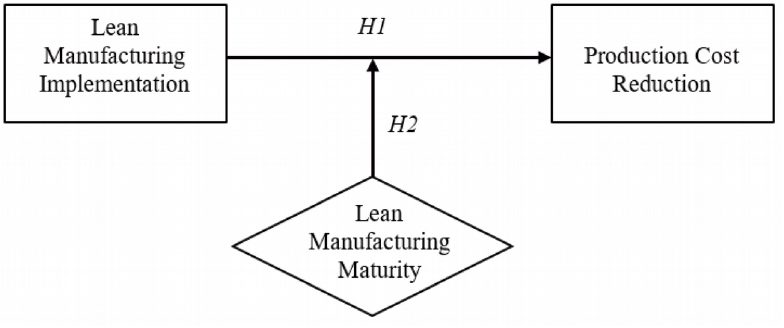
Figure 1. Theoretical